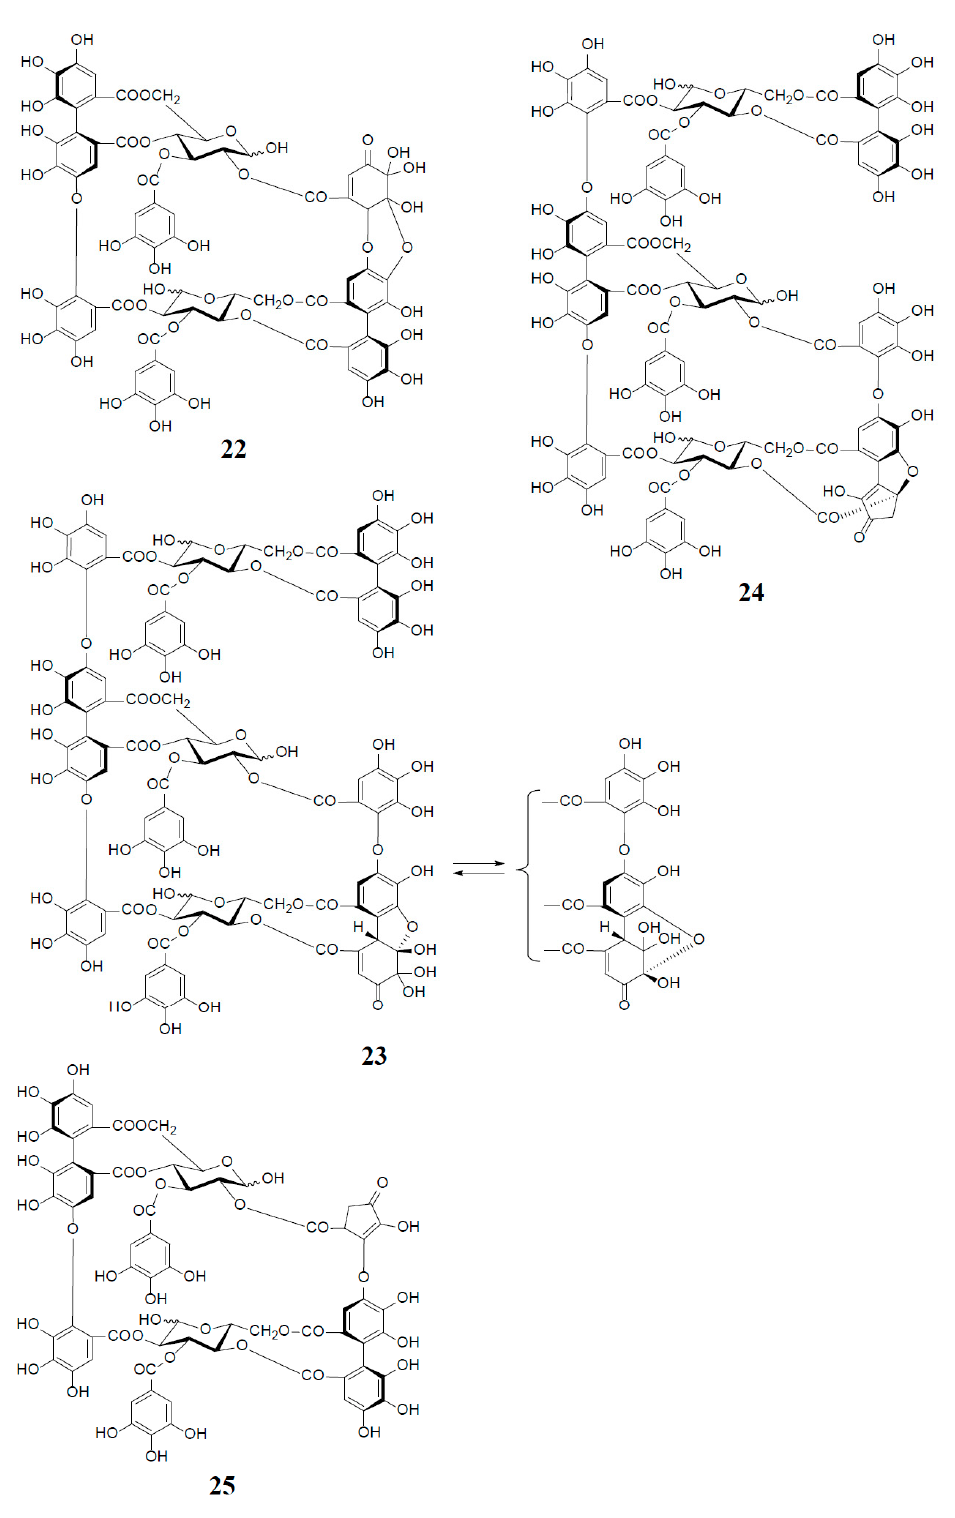
Figure 5. Structures of eugeniflorin D 2 ( 22 ), oenotherins T 1 ( 23 ), T 2 ( 24 ), and eurobustin C ( 25 ).